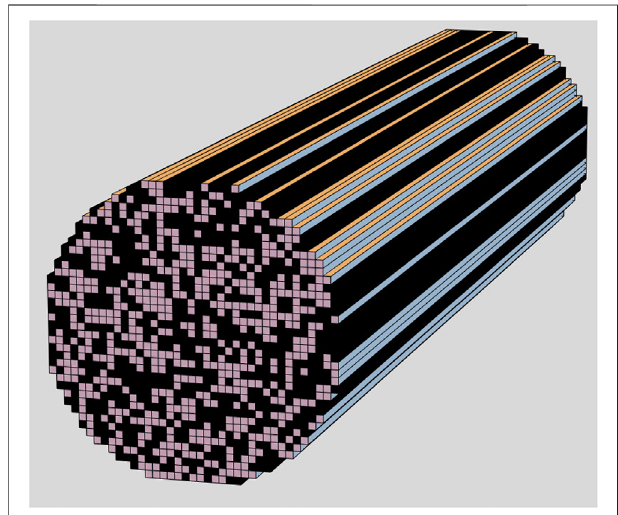
FIGURE2 | Aconceptualsketchofthe random dielectric mediumby De Raedt etal. [57]fortheobservationoftheTALoflight.Thecross-sectionpixels represent the refractive index values of n 1 and n 2